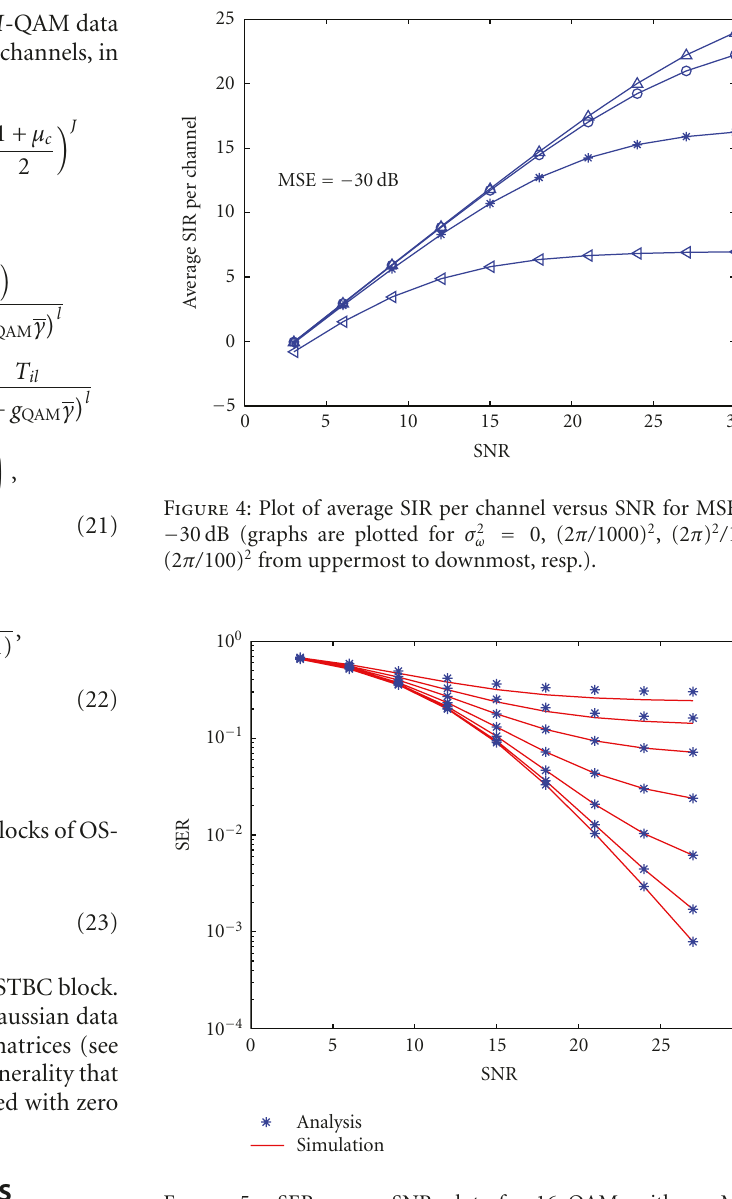
Figure 5: SER versus SNR plots for 16 QAM, with no MSE = (2 π ) 2 / 10000, (2 π ) 2 / 20000, (2 π/ 200) 2 , (graphs are plotted for σ 2 ω (2 π/ 300) 2 , (2 π/ 500) 2 , (2 π/ 1000) 2 , 0 from uppermost to downmost,